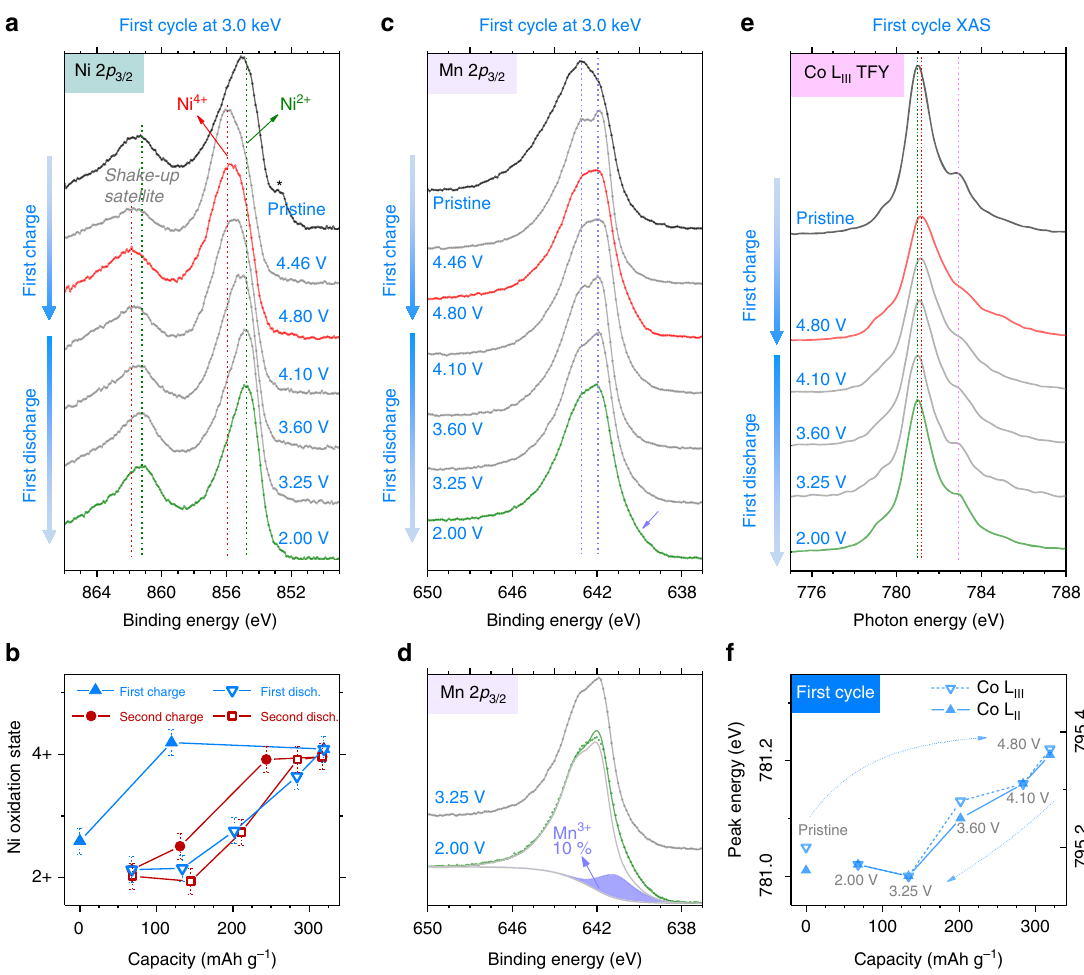
Fig. 3 Charge compensation from transition metals (cationic redox) as deduced by HAXPES and XAS. a Evolution of Ni 2 p 3/2 photoelectron spectra during the fi rst cycle at 3.0 keV (probe depth ≈ 12 nm). The main peak at 855 eV shifts to higher BEs on charge (oxidation from Ni 2+ to Ni 3+ to Ni 4+ ) and vice versa. A small degradation of the pristine sample under X-ray beam is marked by *. b From the BE shift of the main peak, the average Ni oxidation state is estimated as a function of capacity during two cycles. The error bars are determined from the 0.1 eV error in the estimation of the main peak ’ s maximum. c Evolution of Mn 2 p 3/2 photoelectron spectra during the fi rst cycle at 3.0 keV (probe depth ≈ 13 nm). The fi ne structure of the main peak maximum evolves along the two dashed lines. A small shoulder on discharge to 2.00 V (marked by arrow) indicates minor Mn 3+ . d The Mn 3+ amount is estimated by fi tting the 2.00 V spectrum with two components, namely the spectrum envelope at 3.25 V (which contains only Mn 4+ ) and an additional component (purple peak at ~641 keV) attributed to Mn 3+ . e soft-XAS spectra for Co L III -edge (dipole allowed transition from 2 p 3/2 core level to unoccupied 3 d states) recorded in TFY mode (probe depth ~100 nm) during the fi rst cycle. The peak slightly shifts to higher photon energy indicating Co oxidation on charge and vice versa. f As a function of fi rst cycle capacity, the evolution of Co L III (left) and L II (right) peak energies is